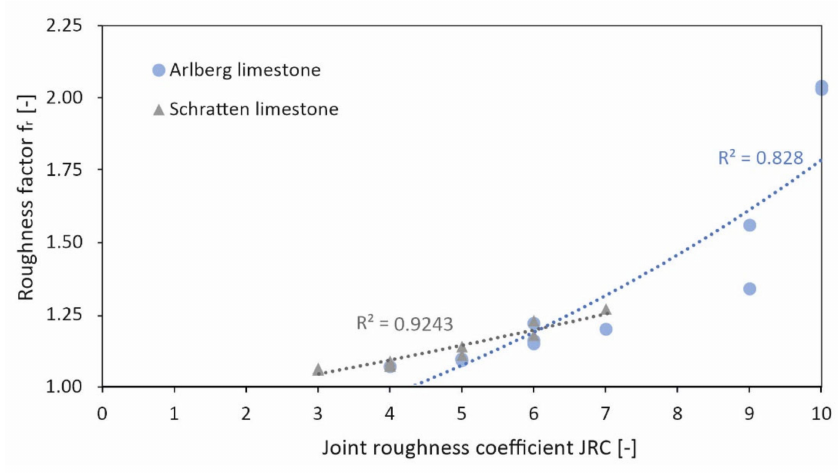
Figure 16. Comparison of the joint roughness coefficient JRC [16] with roughness factor f r of two different types of limestone.